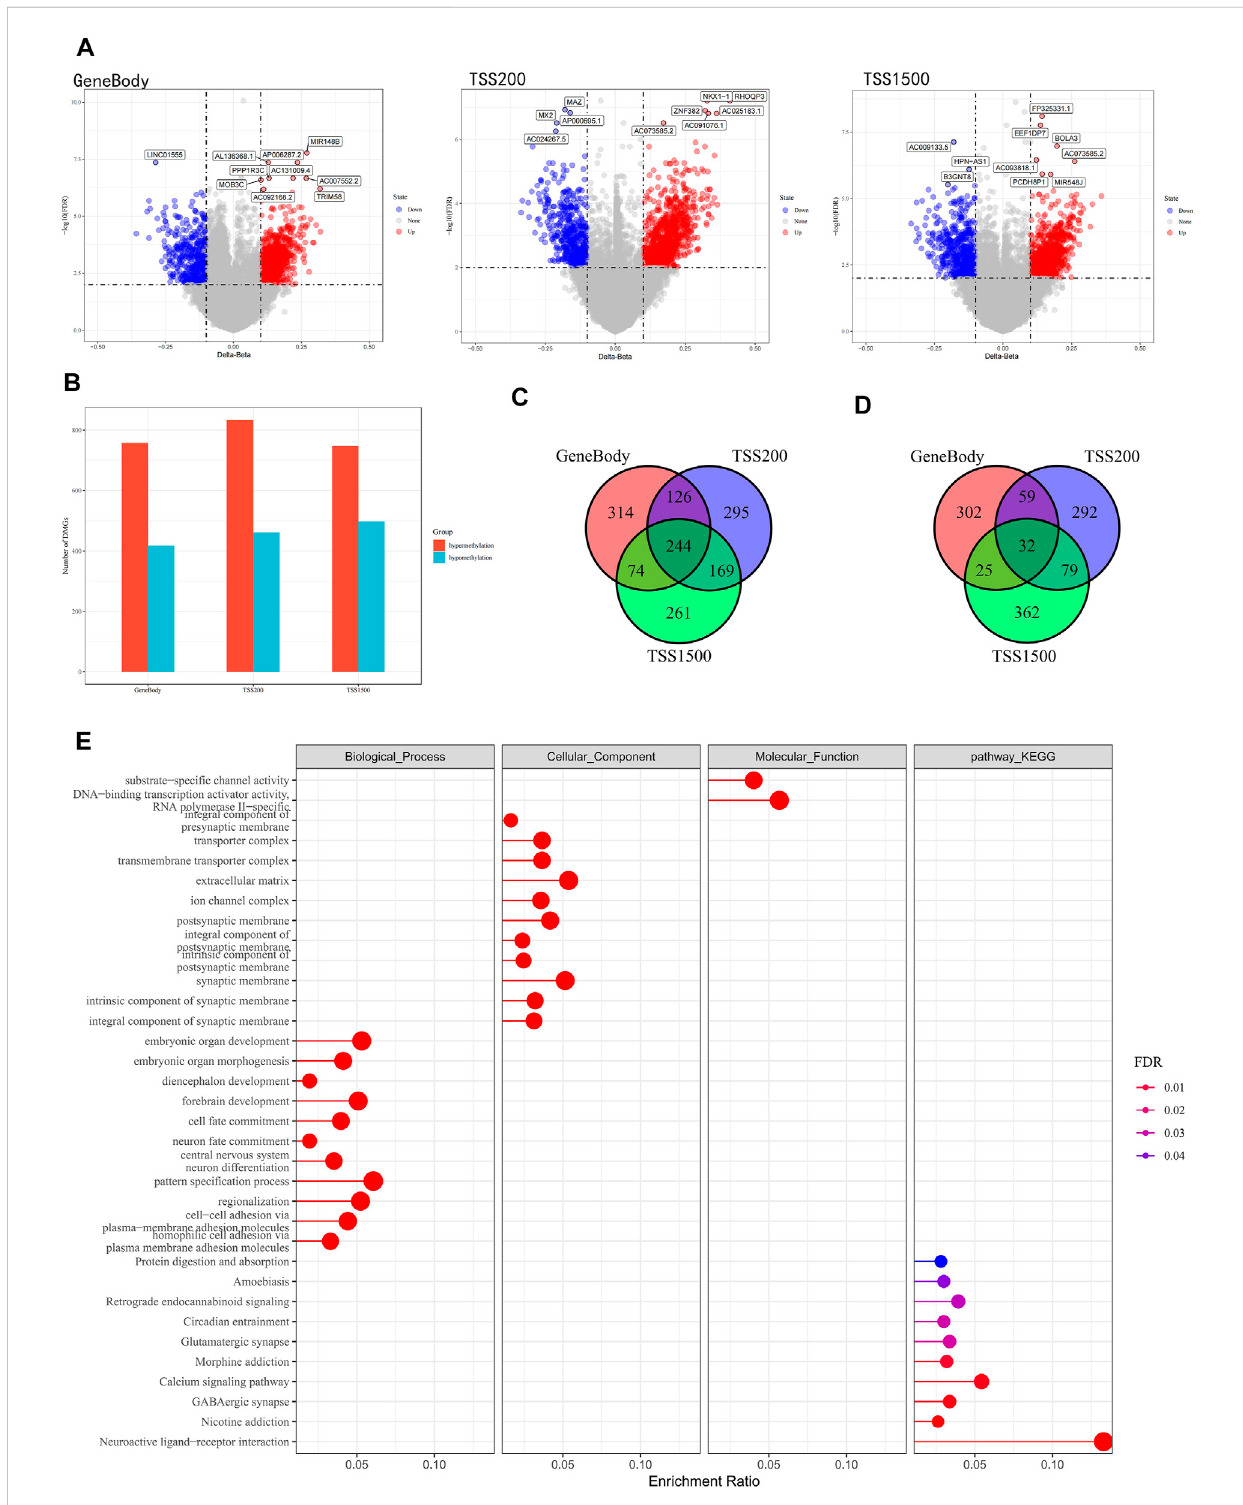
FIGURE 1 Analysis of PAAD differentially methylated genes. (A) Volcano plot of differentially methylated within the gene body, TSS200 and TSS1500 regions. (B) Histograms of differentially methylated genes within the three regions. (C) Venn diagram of hypermethylation within three different regions. (D) Venn diagramsofdemethylatedgeneswithinthreedifferentregions. (E) KEGGandGOfunctionalenrichmentanalysisofdifferentiallymethylatedgenes,where thecolorfrombluetoredindicatesthattheFDRisfromlargetosmall, andthedotsfromsmalltolargerepresent theincreasingnumberofenriched genes, left: hypermethylation, right: